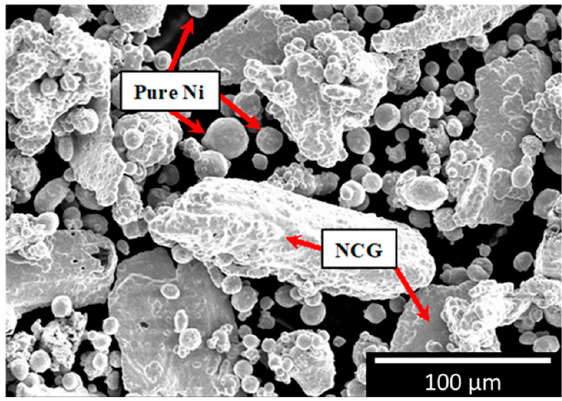
Figure 3. SEM image showing a mix of a pure nickel and NCG powder.